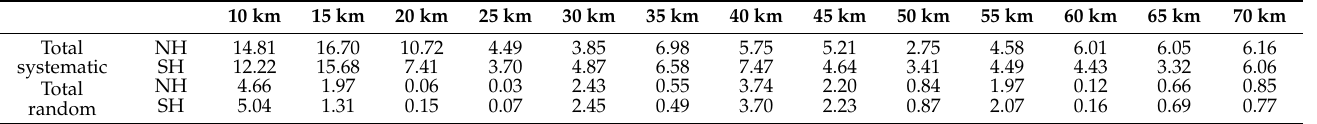
Table 2. Total systematic and random uncertainties (%) for both